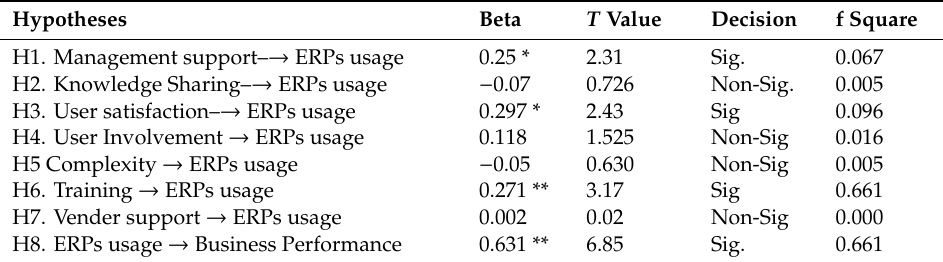
Table 7. Structural estimates (hypotheses testing).